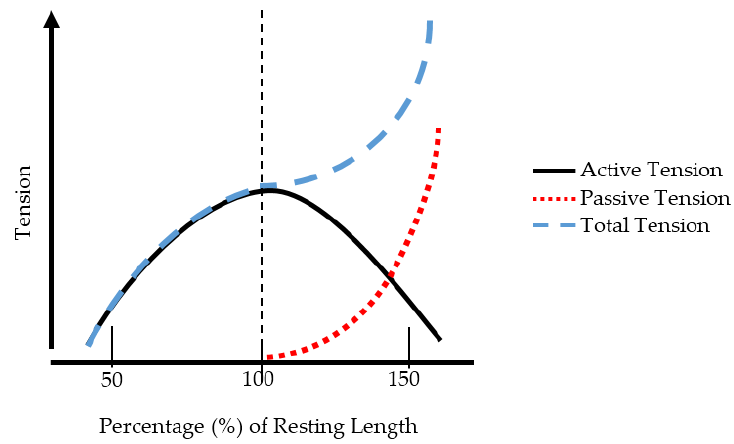
Figure 1. The force-length relationship characteristics for skeletal muscle.